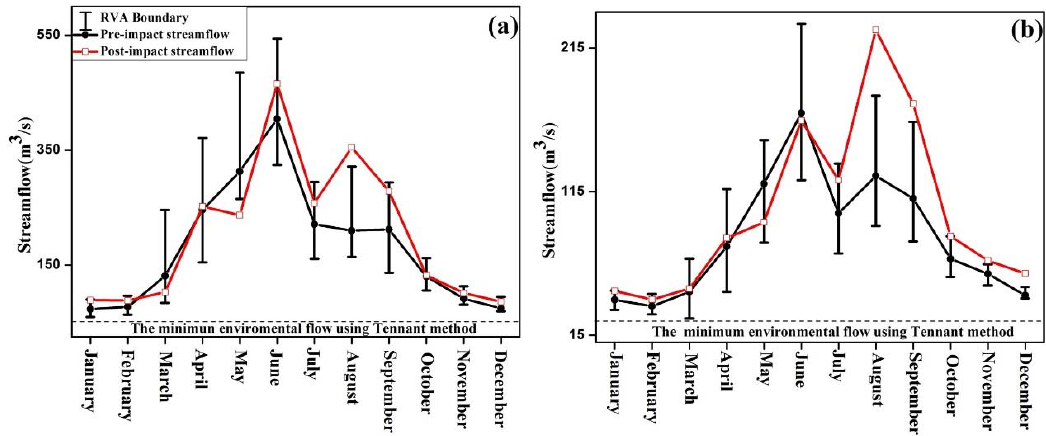
Figure 10. The suitable ranges of the monthly streamflow in the JRW. ( a ) North River reach; ( b ) West River reach.